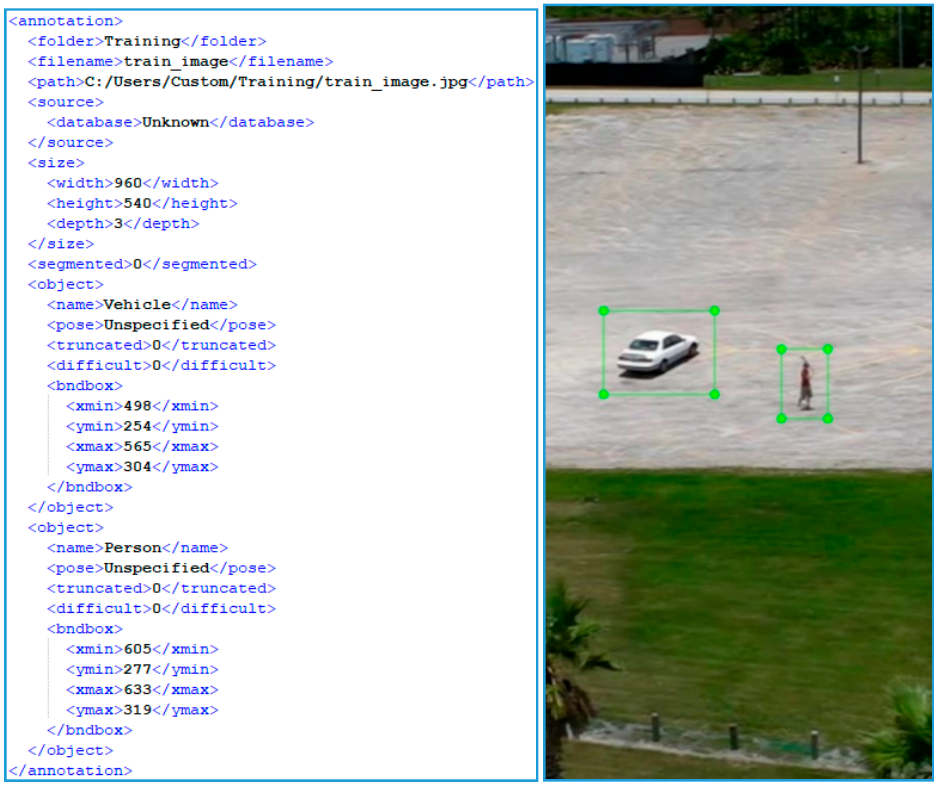
Figure 11. Left: annotation file; right: the corresponding image subset with the bounding boxes of each sample object (green rectangles). Table 3. Detailed information for the datasets used for the custom YOLOv3.